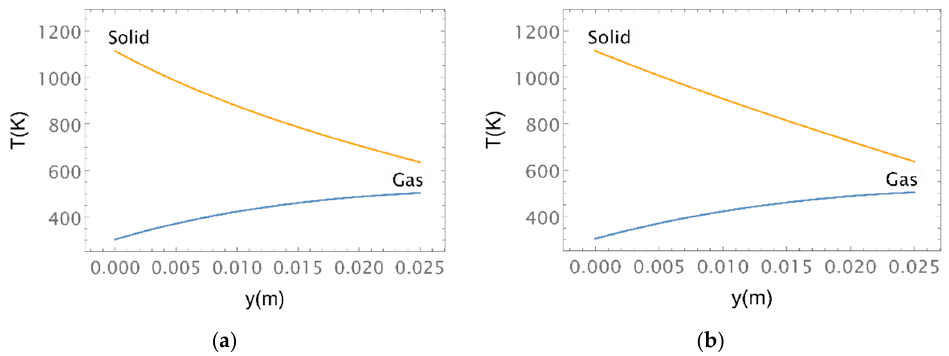
Figure 10. Temperature of the solid and the gas as a function of depth, from the analytical model, for the 20 PPI absorber with different air flowrate. ( a ) 30 L min − 1 and ( b ) 10 L min − 1 .